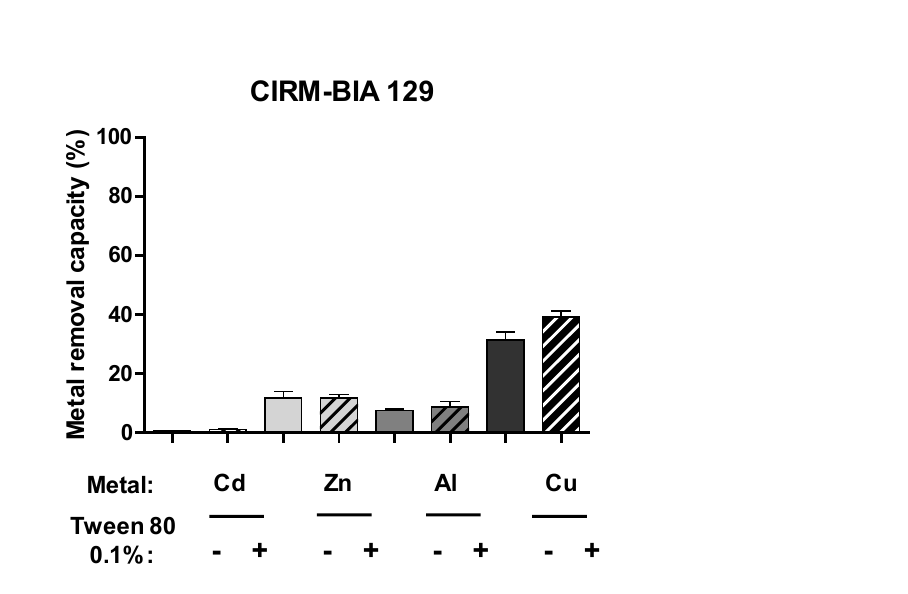
Figure 4. P. freudenreichii CIRM-BIA 129’s ability to remove Cd(II), Zn(II) Al(III) and Cu(II) with (hatched bars) our without (solid bars) 0.1% Tween ® 80 treatment. The data are expressed as the mean ± SD % of metal removed from the solution (starting concentration: 25 ppm) in triplicate ex- periments.